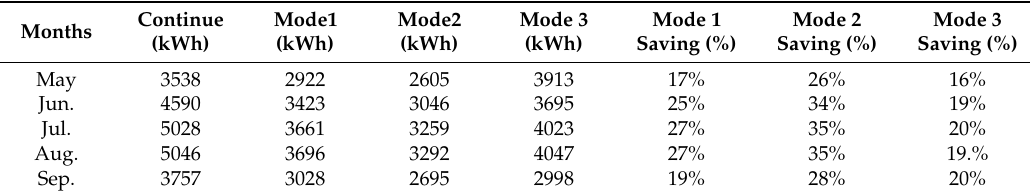
Table 4. Monthly energy consumption under the continuous and different modes of AC operation for House 1 during the summer.